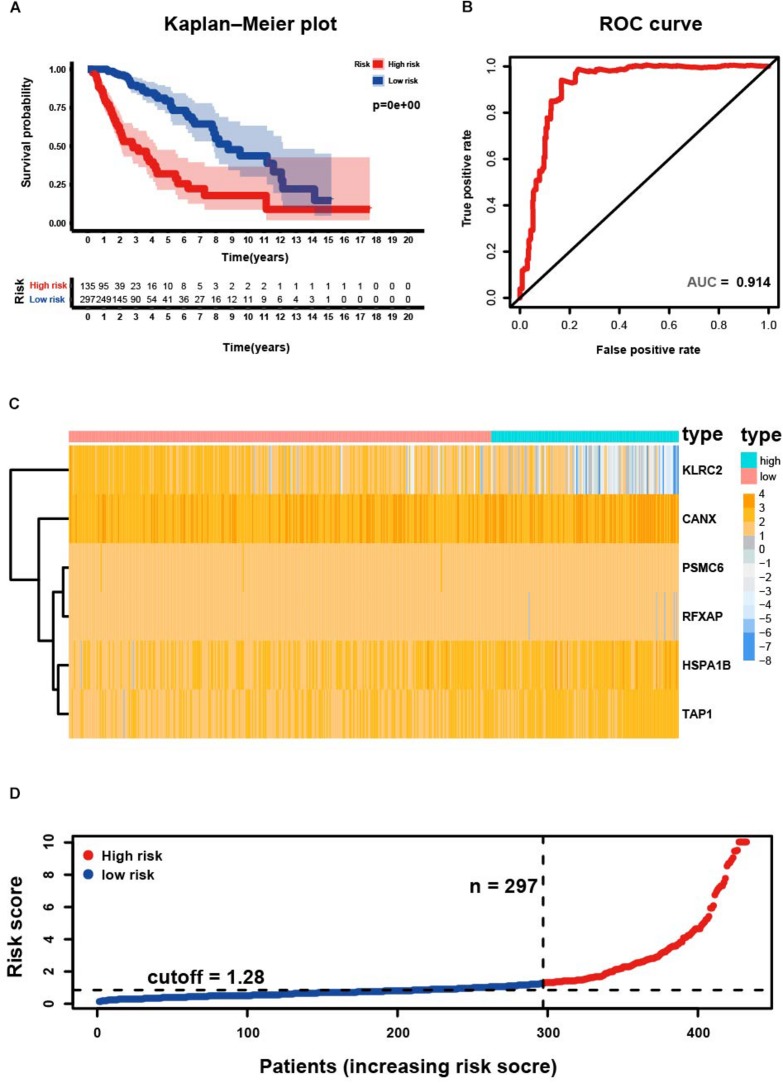
Development of risk score based on the six immune-related gene signature of patients with primary LGG in TCGA. (A) Kaplan-Meier plot for overall survival (OS) based on risk score of the six gene based signature of patients with primary LGG in the TCGA cohort. (B) ROC curve with an AUC of 0.914, indicating that risk score plays a significant performance in the efficacy of this diagnosis. (C) Heatmap demonstrating the distribution of the six immune-related gene expression in the TCGA cohort. (D) Risk plot presenting each point sorted based on risk score, representing one patient. Blue, and red represent patients with low- and high-risk, respectively.